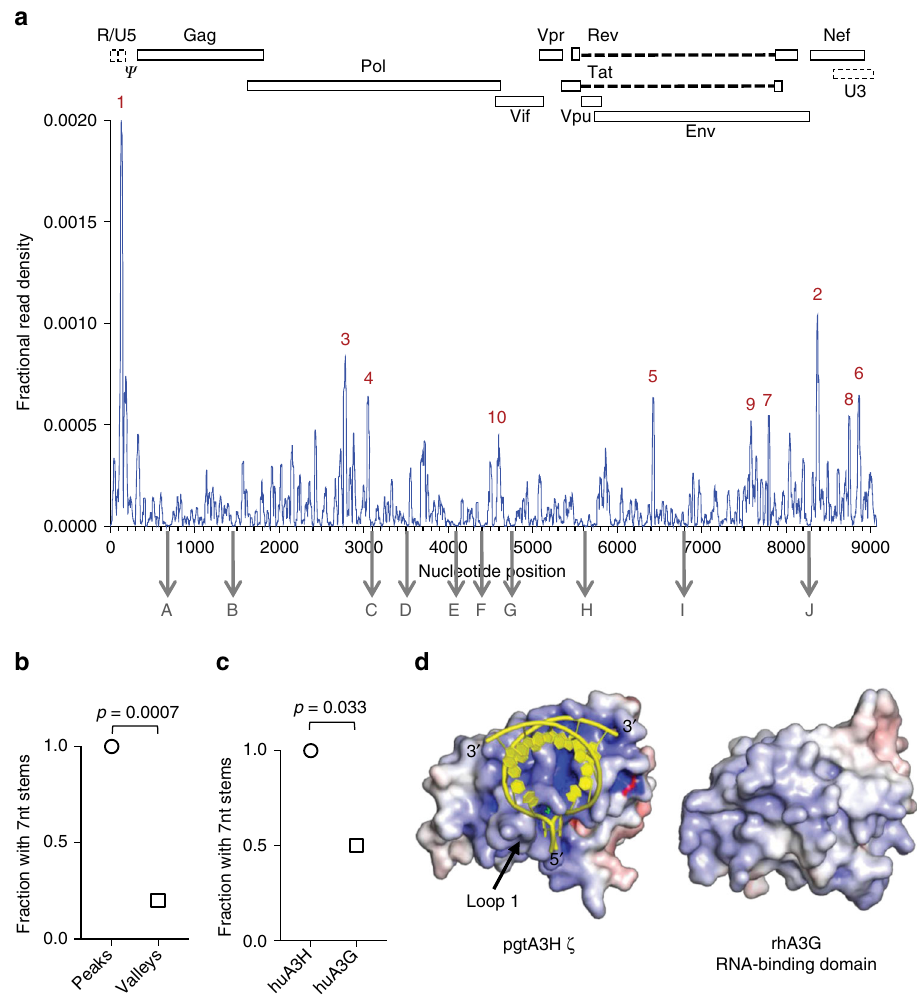
Mutagenesis . The catalytically inactive variant of pgtA3H α was generated by PCR and con fi rmed by sanger sequencing. Primers were designed with the Quikchange primer design tool website (Agilent) and are included in Supple- mentary Table 1.